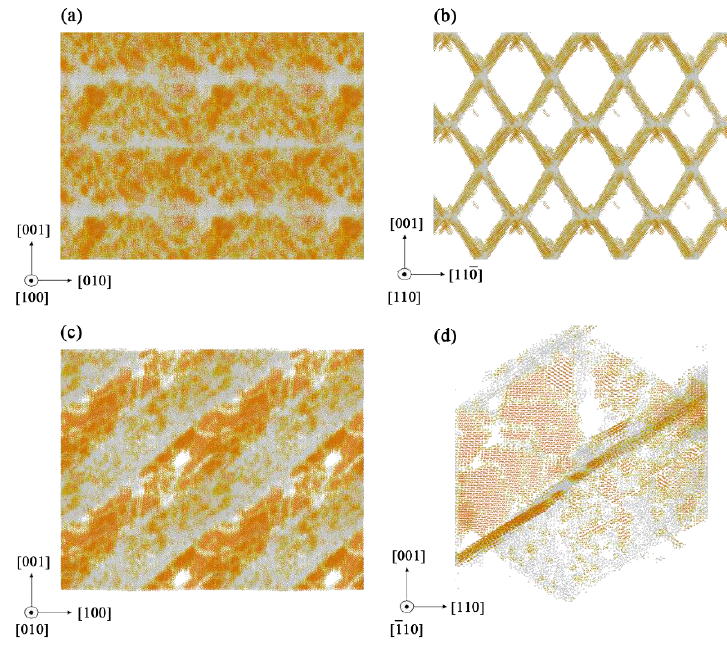
Figure 11. Fractured microstructures caused by tensile stress from (100) crystal direction in monocrystalline silicon: ( a ) Camera view of (100) direction; ( b ) camera view of (110) direction; ( c ) camera view of (010) direction; ( d ) grid structure in single cell model.